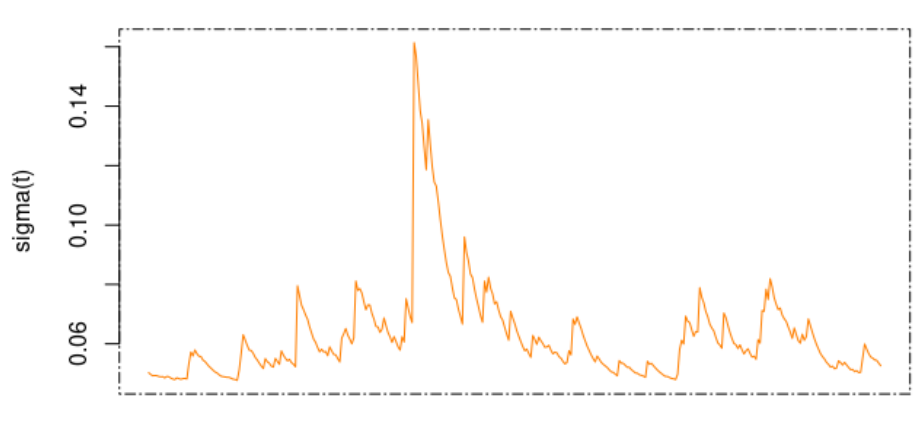
Figure 14. Volatility extracted from AR(1)-GJR-GARCH(1,1) model for Ethereum (ETHER)— CoinMarketCap.